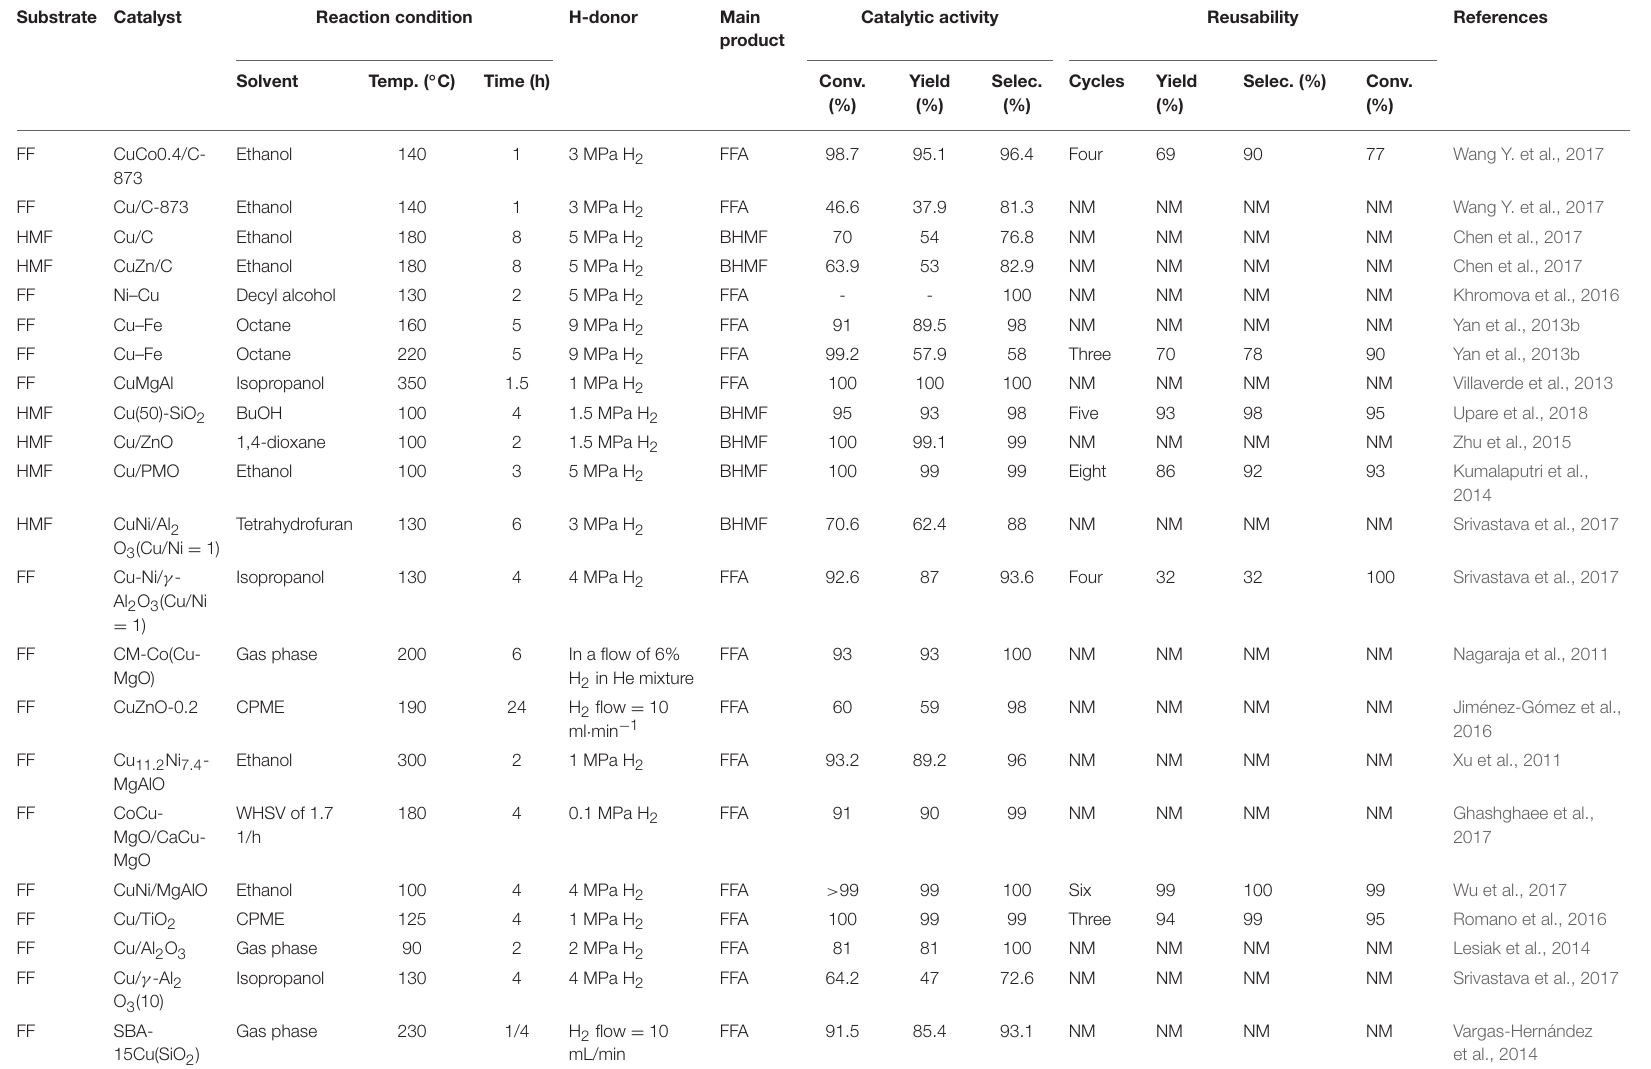
TABLE 1 | Hydrogenation of FF and 5-hydroxymethylfurfural catalyzed by different non-precious metallic catalysts. Substrate